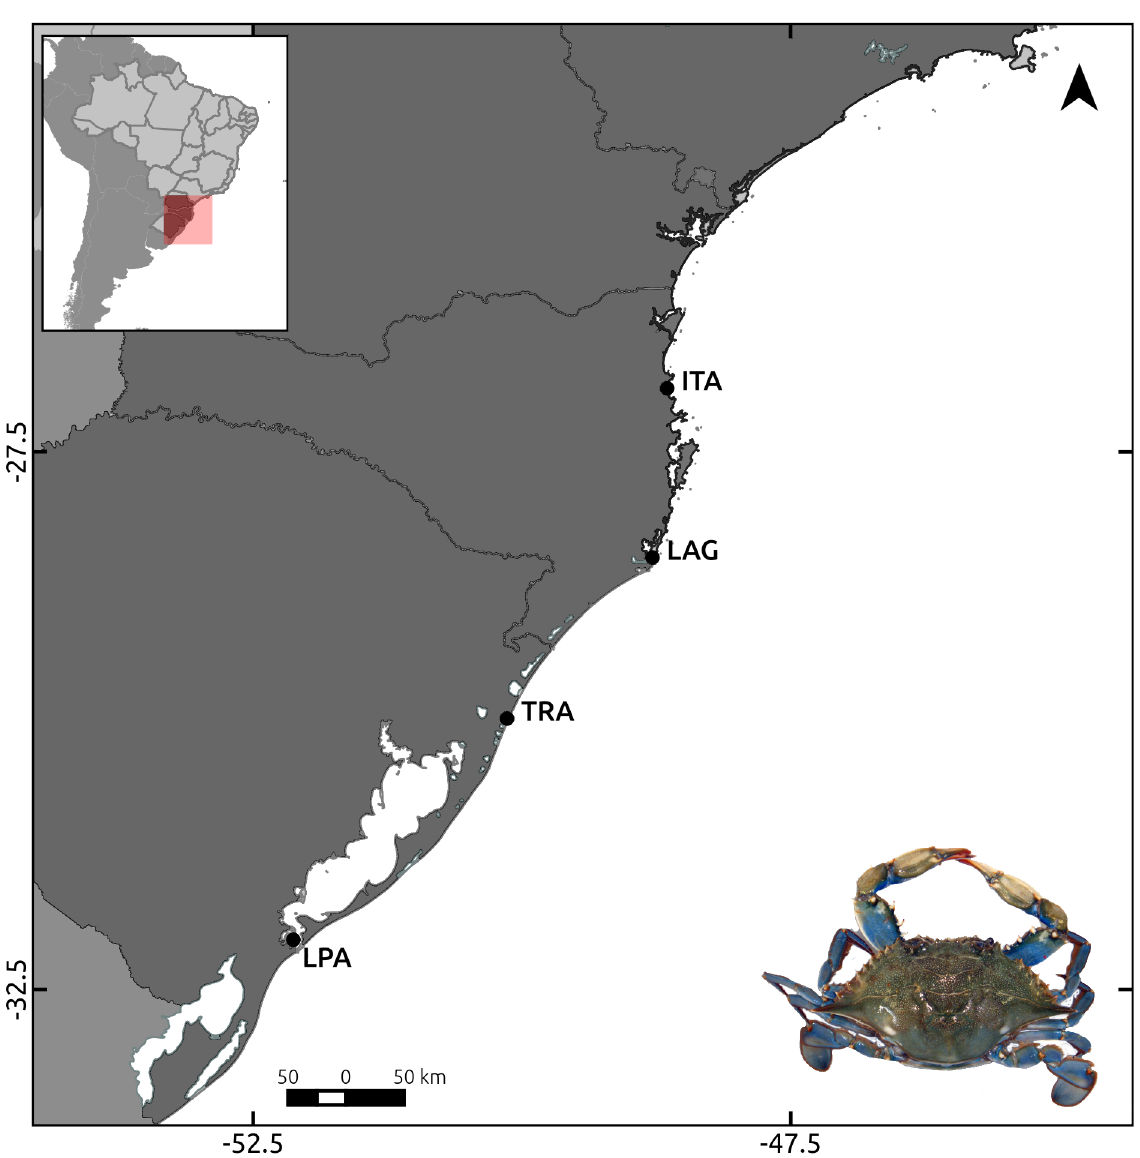
Fig 1. Callinectes sapidus sampling areas in the Western South Atlantic. LPA = Lagoa dos Patos; TRA = Tramandaí; LAG = Laguna; ITA = Itajaí.